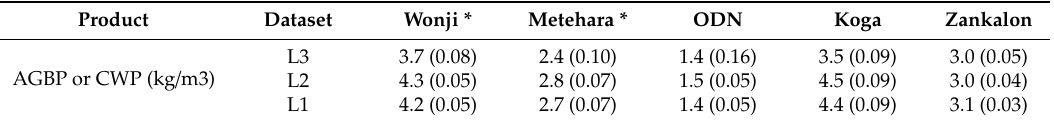
Table 6. Mean annual scheme crop water productivity (CWP) (CWP denoted with *) or AGBP WP for 2009–2018 for all schemes (scheme CV in brackets).